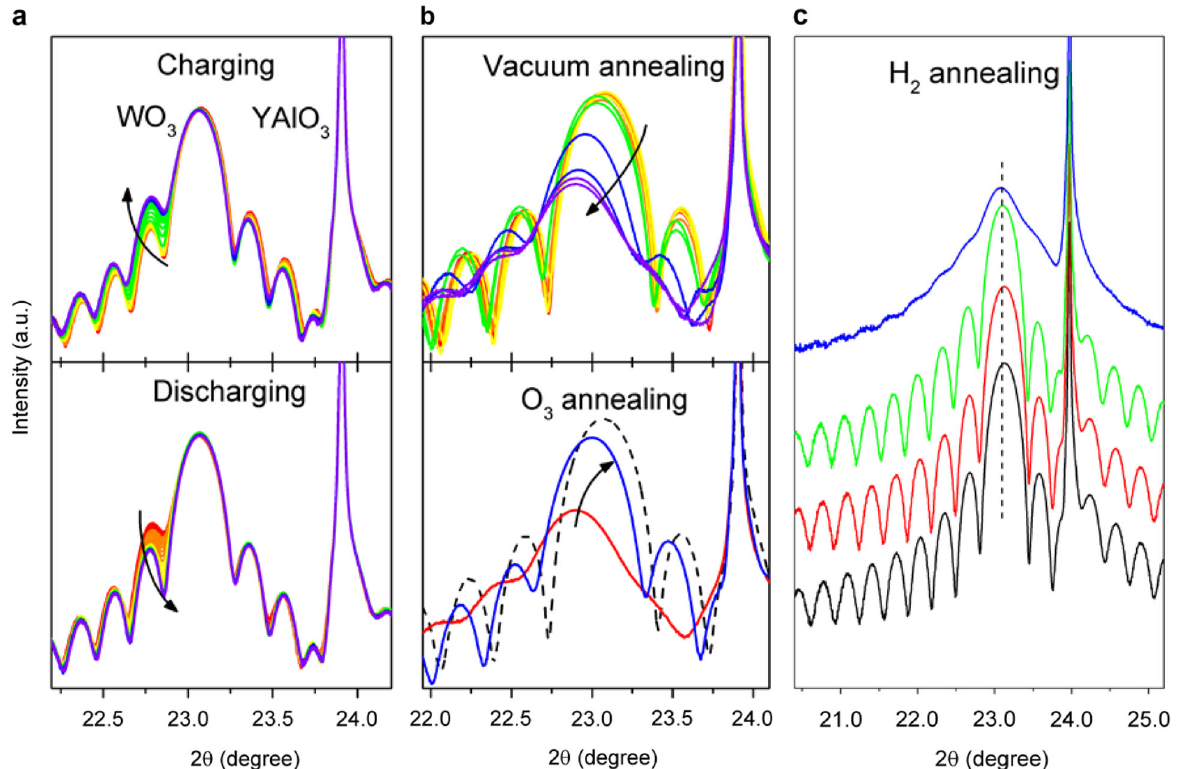
Fig. 5 XRD curves measured during charging and discharging processes and compared with those measured after a series of vacuum, ozone, and hydrogen annealing procedures. a , XRD curves measured during charging (top) and discharging (bottom) processes. The electrolyte is PEG-NaF and the curves are measured at room temperature. The maximum charging gate voltage is V G = 3 V ( − 3 V for the discharging process). The (002) WO 3 Bragg peak shows negligible shifts (~ 0.01°) while the fi rst fringe changes signi fi cantly. b , XRD curves measured after a series of vacuum and ozone annealing procedures in sequence. Top, following the direction of the arrow: the fi rst one is the original (as-grown) fi lm; the next 7 curves were measured after the fi lm was annealed for 2 h in 10 − 6 Torr vacuum at 400, 400, 450, 450, 500, 500, and 520 °C; the last four curves were measured after the fi lm was annealed at 550 °C for two hours each. No obvious changes can be seen if the annealing temperature is below 520 °C. However, increasing the annealing temperature to 550 °C shifts the (002) WO 3 Bragg peak to a lower angle by 0.16° and the thickness fringes smear out during this process. Bottom, the same WO 3 /YAlO 3 fi lm was then annealed in an O 3 /O 2 mixture at 450 °C for 1 h following the vacuum annealing procedure. The red curve is the one measured after the vacuum annealing procedure and the dashed line represents the original (as-grown) fi lm. The blue curve is measured after ozone annealing and shows that the (002) WO 3 Bragg peak moves back towards the original position. c XRD curves measured after the fi lm was annealed in hydrogen forming gas at different temperatures in sequence. From bottom to top: the fi rst one is the original fi lm, the next three are measured after the sample was annealed in hydrogen forming gas (mixture of H 2 and Ar) at 300, 500 and 520 °C for 1 h. The (002) WO 3 Bragg peak does not change at all during the hydrogen annealing process while the fringes smear out after the fi nal annealing